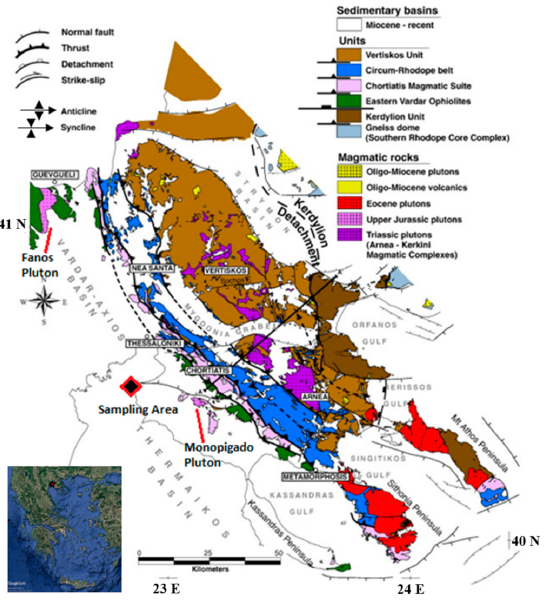
Figure 1. Geological sketch of the wider area ([3] after